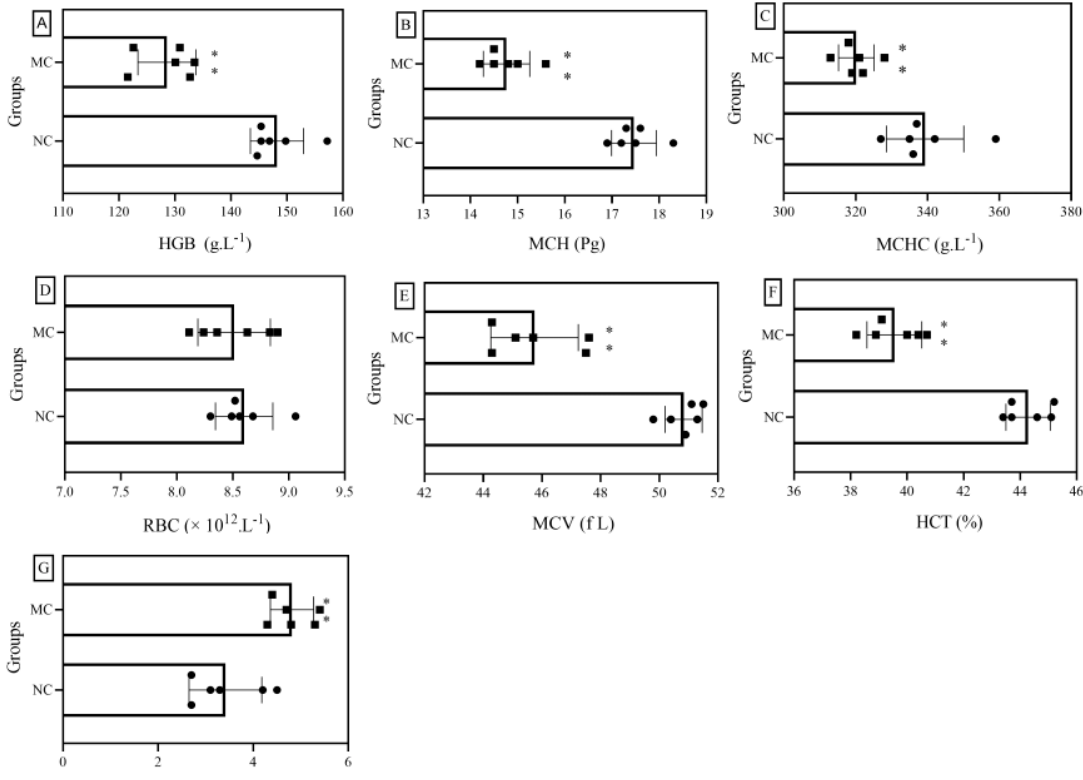
Figure 3. Effects of cadmium exposure on hematological indicators of mice: ( A – G ) are HGB, MCH, MCHC, RBCs, MCV, HCT, and WBCs, respectively. NC: normal control group, MC: CdCl 2 -treated group. * Compared with normal control group (NC group), ** p <